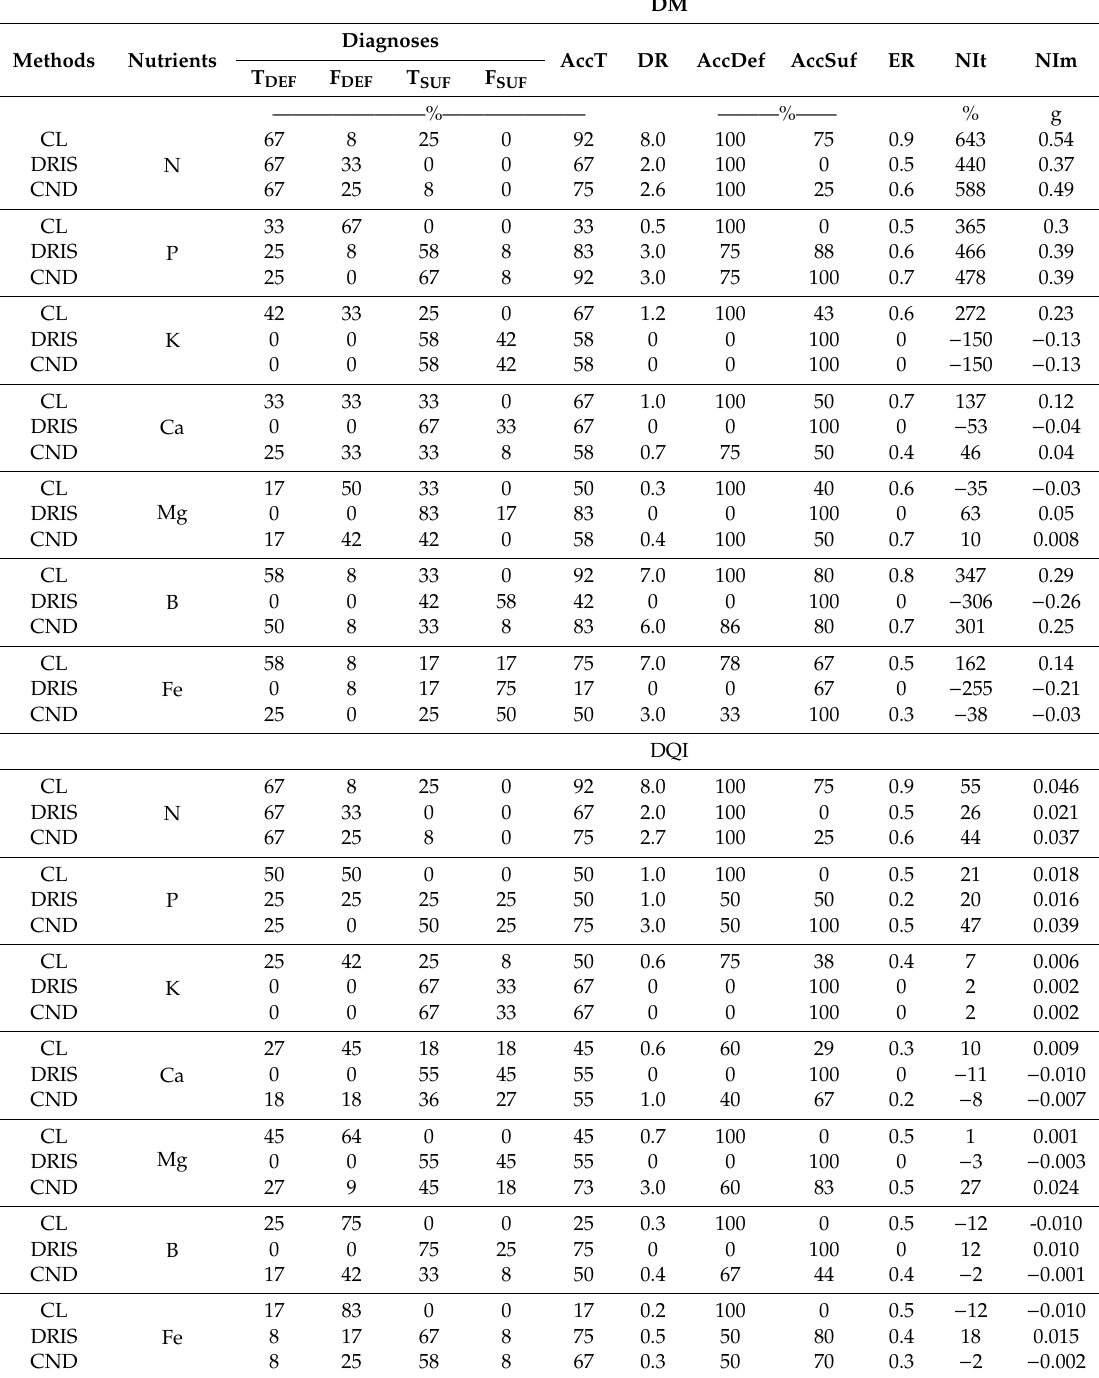
Table 6. Nutritional diagnosis performance for N, P, K, Ca, Mg, B and Fe in Eucalyptus spp. clonal rooted cuttings for DM and DQI associated with true and false